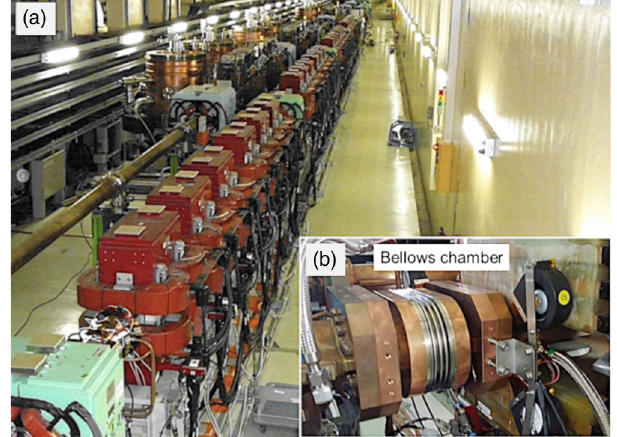
FIG. 28. (a) Wiggler section in the LER (Oho) and (b) bellows chamber with cooling blowers.